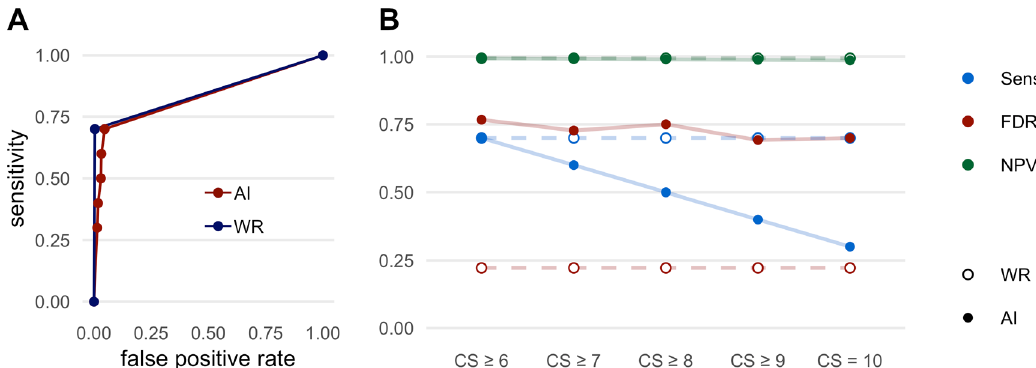
Figure 6. Performance metrics for the detection of pneumothoraces. ( A ) Receiver operating characteristic (ROC) curves displaying the performance of the AI Rad Companion Chest X-ray (AI) and the radiologists (WR = written report) for the detection of pneumothoraces (area under the curve (AUC) AI = 0.830/ WR = 0.848). ( B ) Sensitivity (Sens.), negative predictive value (NPV) and false discovery rate (FDR) of the AI Rad Companion Chest X-ray (AI) and the radiologists (WR = written report) for the detection of pneumothoraces. CS = confidence score.